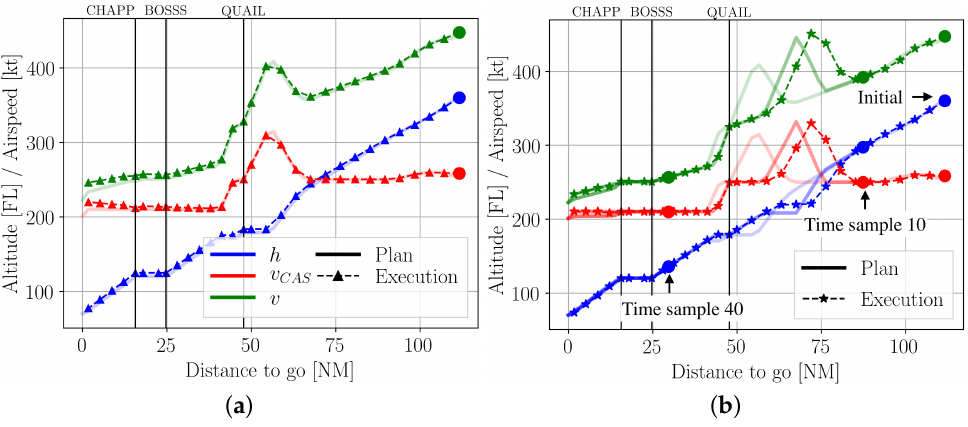
Figure 4. Planned and executed trajectories by control method (21 April 2018 00:00 with a look-ahead time of +1 h). ( a ) Open-loop. ( b )